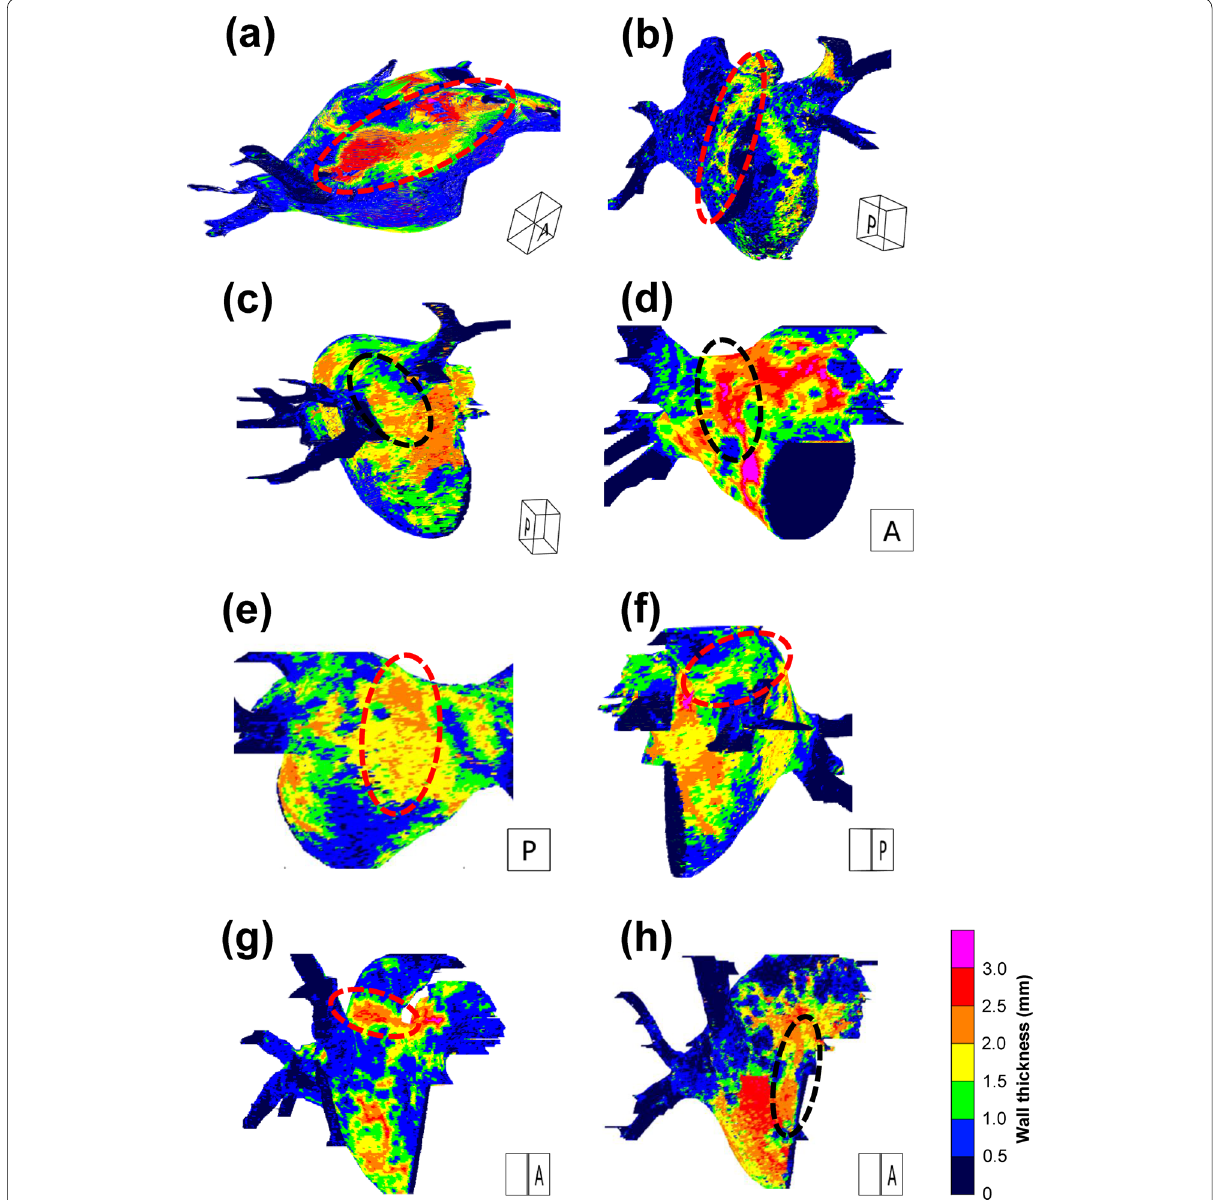
Fig. 4 Prominent myofibers in the left atria. Representative examples are indicated with dashed lines. a Bachmann’s bundle (RAO cranial view). b RPV posterior bundle (RPO cranial view). c RPV carina bundle (RPO cranial view). d Septopulmonary bundle (AP view). e LA posterior bundle (PA view). f LPV carina bundle (LPO view). g LSPV superior bundle (RAO view). h septoatrial bundle (RAO view). AP anterior–posterior, AWT atrial wall thickness, PA posterior‑anterior; LPO left posterior oblique; LPV left PV, LSPV left superior PV, RAO right anterior oblique, RPO right posterior oblique, RPV right